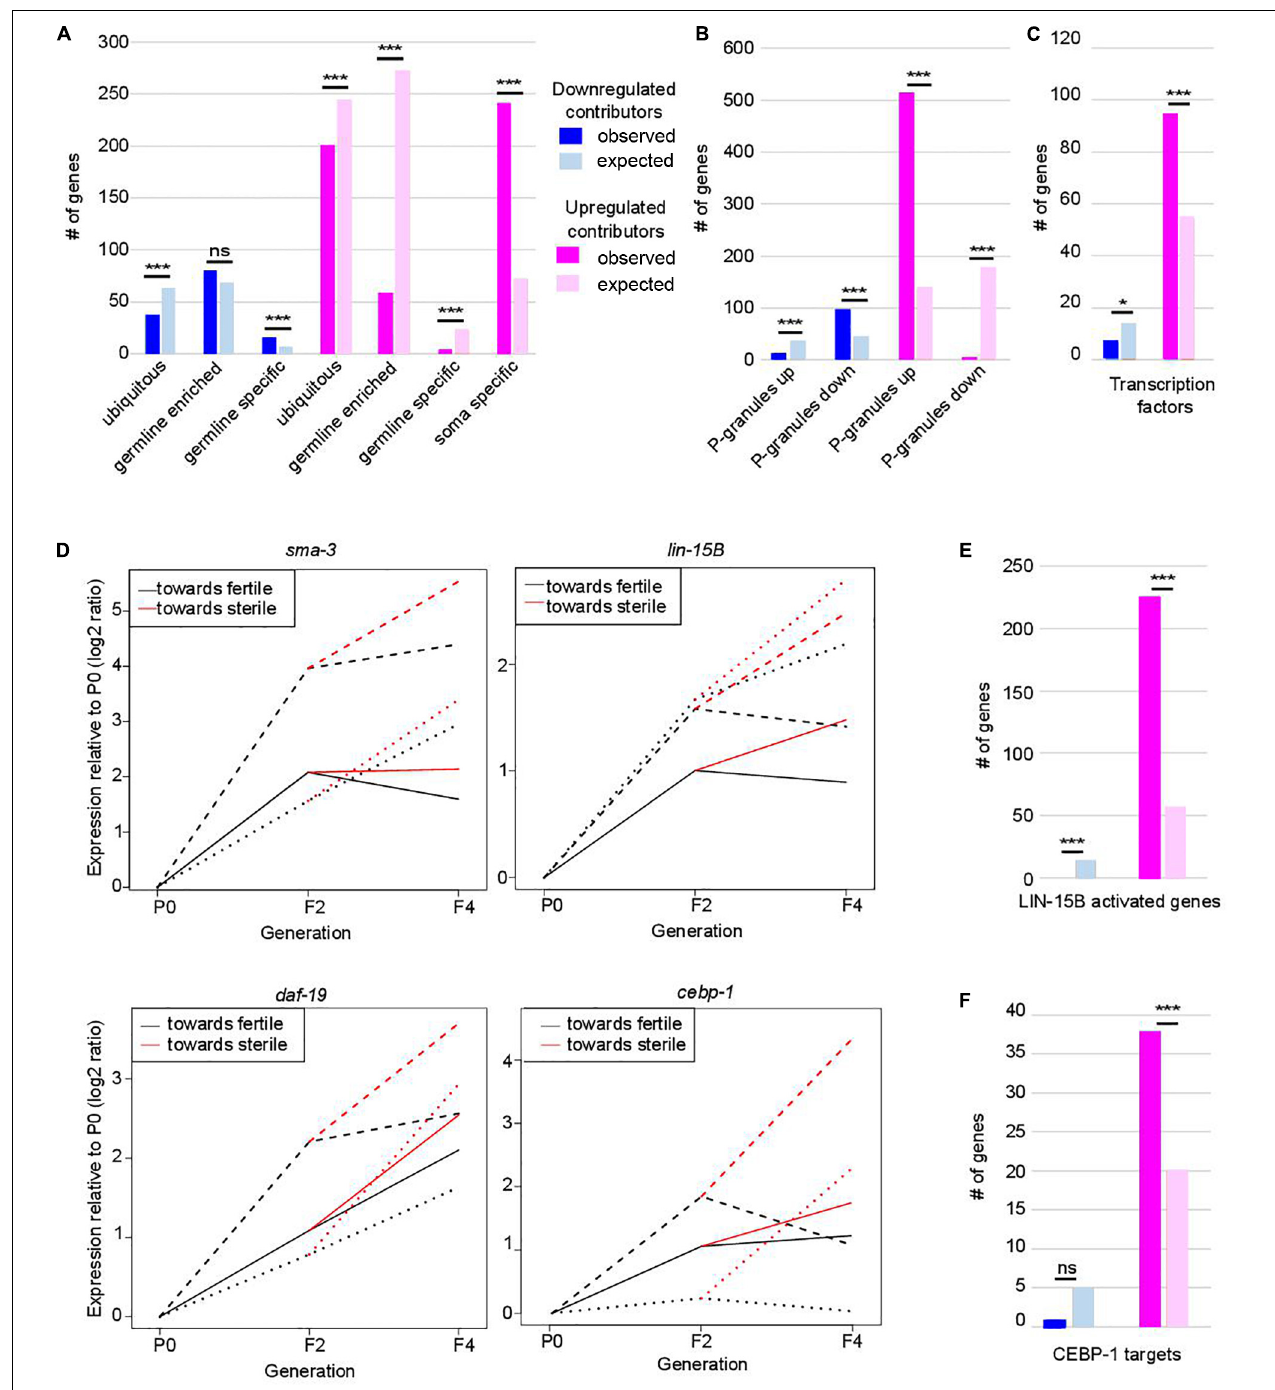
FIGURE 2 | Functional classification of contributors to set- 2 dependent loss of germline identity. In (A–C,E,F) * p -value < 0.05 and *** p -value < 0.001 calculated by hypergeometric test. (A) Classification of contributors according to their expression profiles in wild-type animals. Lists of down- and upregulated contributors were compared to lists of ubiquitous, germline-enriched, germline-specific, and soma-specific genes defined in (8). Downregulated contributors are depleted for ubiquitous genes ( p = 2.3e-4) and enriched for germline-specific genes ( p = 2e-4); upregulated contributors are depleted for ubiquitous genes ( p = 1.3e-4), germline-enriched genes ( p = 2.41e-119), and germline-specific genes ( p = 2.41e-119), and enriched for soma-specific genes ( p = 2.96e-78). (B) Comparison of lists of contributors with genes up- or downregulated in the gonads of adult worms in which P granules had been depleted by RNAi for 2 generations [PG(–); 8]. Color code for down- and upregulated contributors is the same as in (A) . Downregulated contributors are depleted for genes upregulated in PG(–) ( p = 5.5e-06), and enriched in genes downregulated in PG(–) ( p = 1.1e-15); upregulated contributors are depleted for genes downregulated in PG(–) ( p = 1.4e-90), and